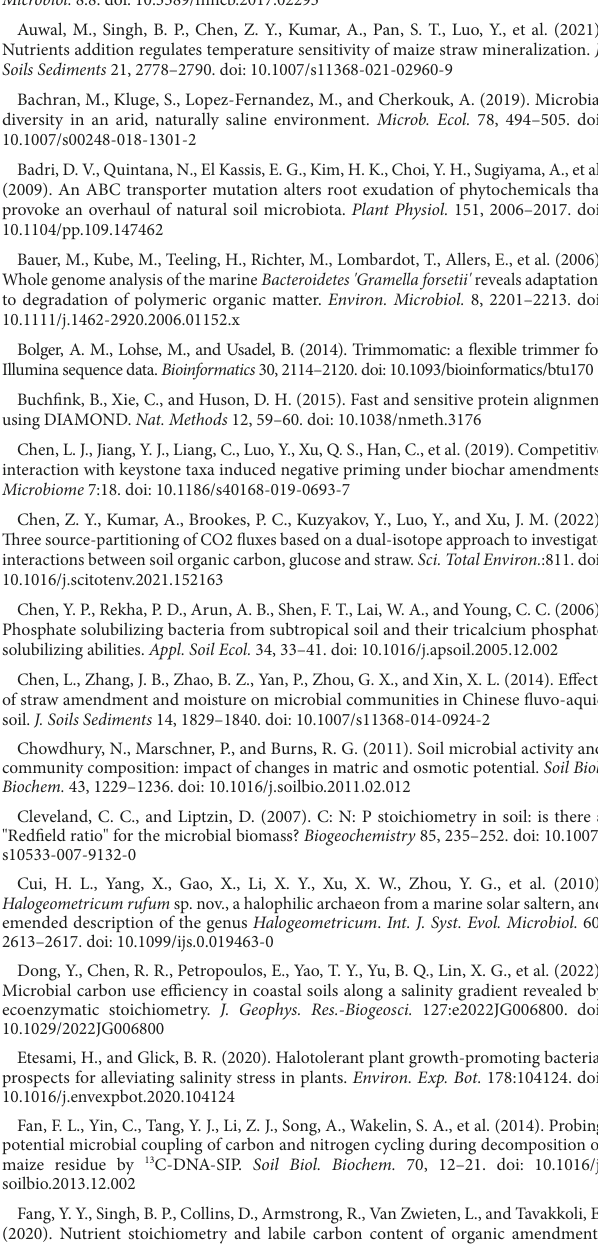
SUPPLEMENTARY FIGURE S2 Genes with significant differences between treatments with or without nutrient additions in low salinity soil. LSC, low-salinity soil added with 13C-glucose; LSCNP low-salinity soil added with 13C-glucose and NP nutrients. SUPPLEMENTARY FIGURE S3 Pearson correlations of microbial CUE and Y-A-S strategies ( A ) and the relationships between Y-A-S strategies based on related genes classification and microbial CUE ( B ). * mean P < 0.05. Y-strategy, growth yield; A-strategy, resource acquisition; S-strategy, stress